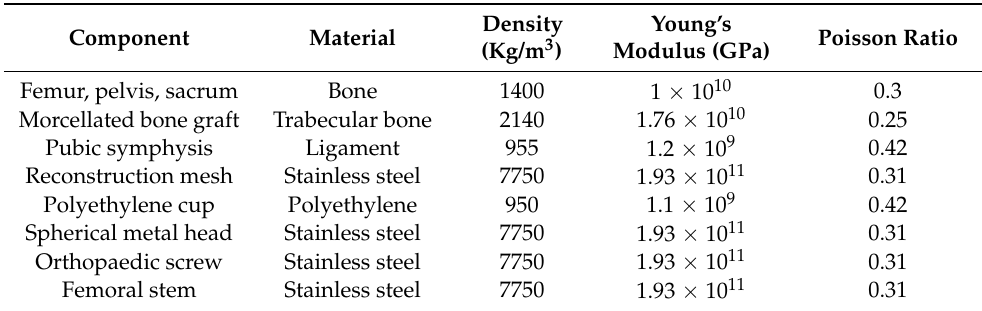
Table 3. Physico-mechanical characteristics of the materials used in the simulation for the system with morcellated bone graft.